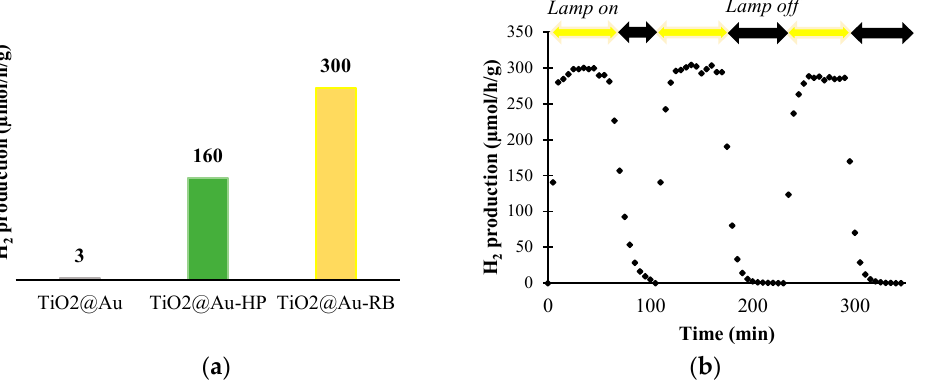
Figure 8. ( a ) Amount of hydrogen produced by photoreduction of water in the presence of gold-doped TiO 2 prepared by microwave heating process (100 mg of photocatalyst, 80 mL water, 20 mL ethanol, λ = 365 nm) ( b ) Evolution of the hydrogen production by photoreduction of water in the presence of TiO 2 @Au-RB during 3 cycles of illumination.